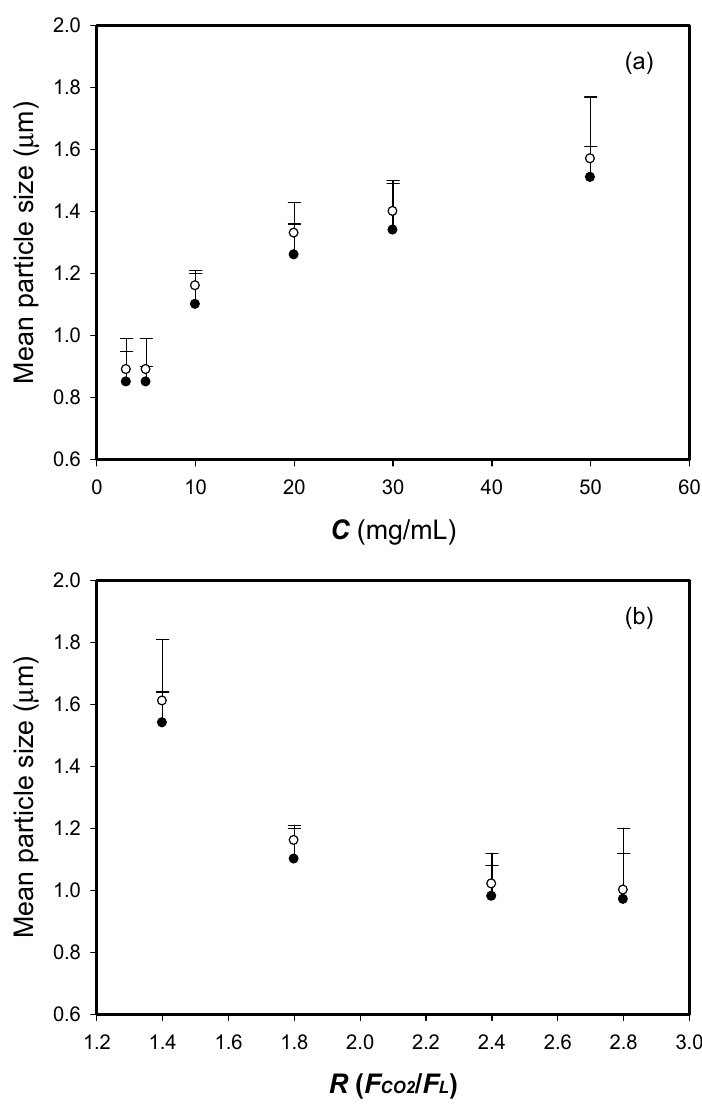
Figure 4. Arithmetic mean size ( d no , ) and mass-weighted mean particle size ( d 4,3 , ) of the HP- β -CD particles varying with SAA process parameters of ( a ) the concentration of the HP- β -CD solution ( C HP ) ( b ) the volume flow ratio of CO 2 to HP- β -CD solution liquid ( R ). The mean particle size ( d 4,3 ) of the micronized HP- β -CD particles produced at differ- ent flow ratios ( R ) in the range of 1.4 − 2.8 (runs #2, and #16 − 18 in Table 1) are shown in